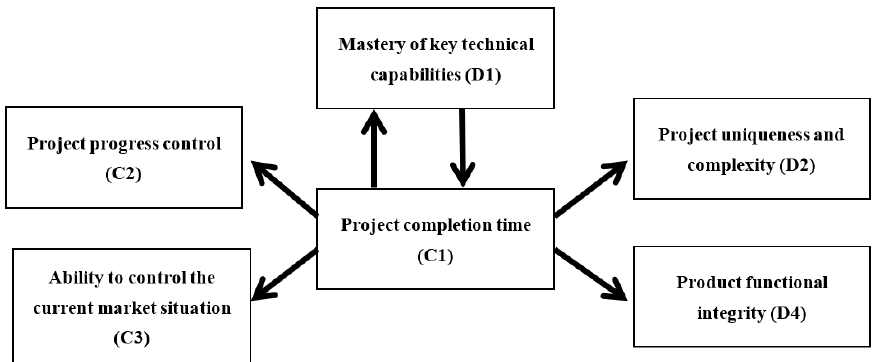
Figure 4. Causal diagram for evaluation criteria.